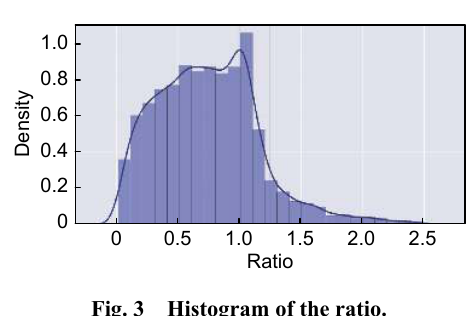
Fig. 3 Histogram of the ratio.